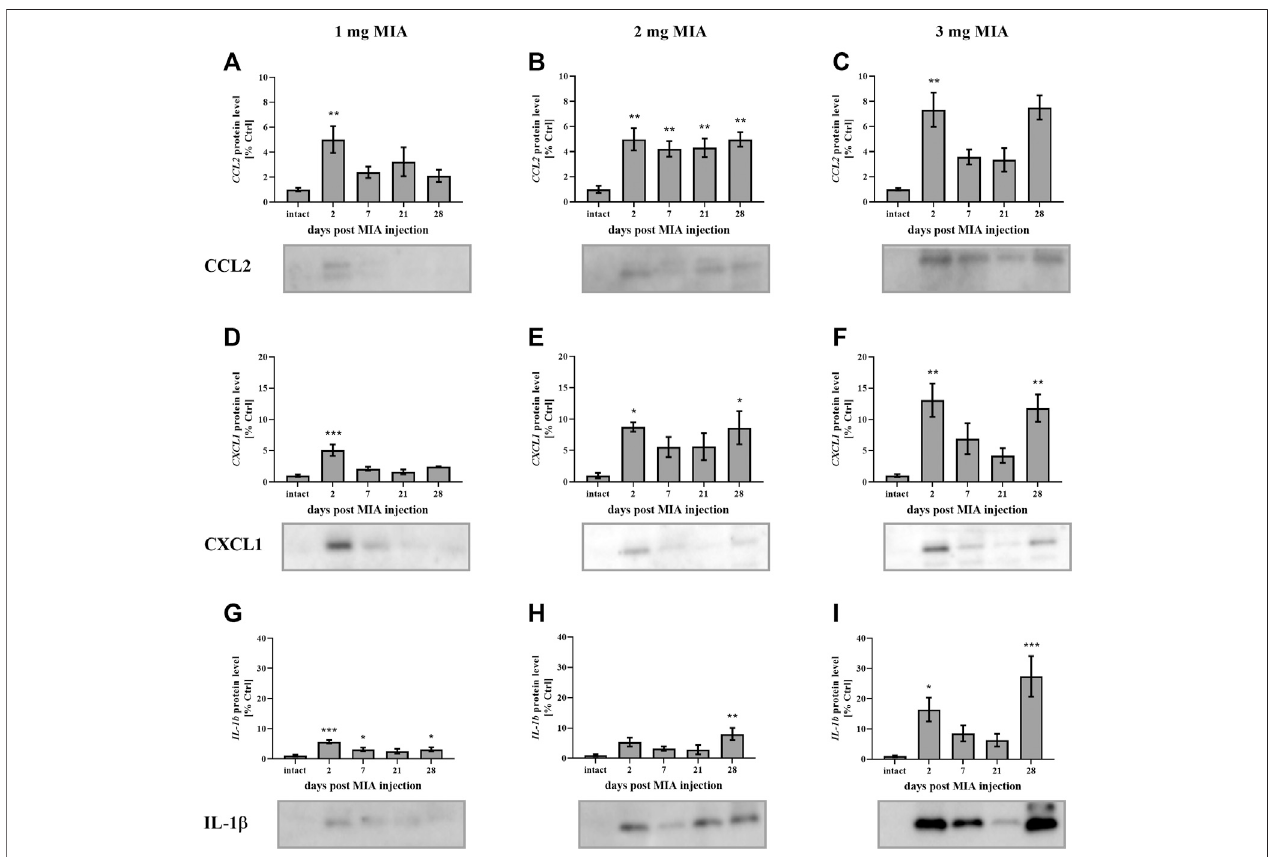
FIGURE5| Changesintheproteinlevelsofthein fl ammation-relatedfactorsCCL2 (A – C) ,CXCL1 (D – F) ,andIL-1 β (G – I) inthesynovial fl uidofosteoarthriticrats,as measured by Western blot assay. Tissues were collected 2, 7, 21 or 28 days after OA induction. The results are presented as the mean group fold change ± SEM in comparisontothecontrolgroup(healthyanimals),n (cid:2) 5 – 6samplesper group.Datawereanalyzedwithone-wayANOVAfollowedbyDunnett ’ sposthoctest. *denotes p < 0.05; ** denotes p < 0.01; *** denotes p < 0.001 vs. intact